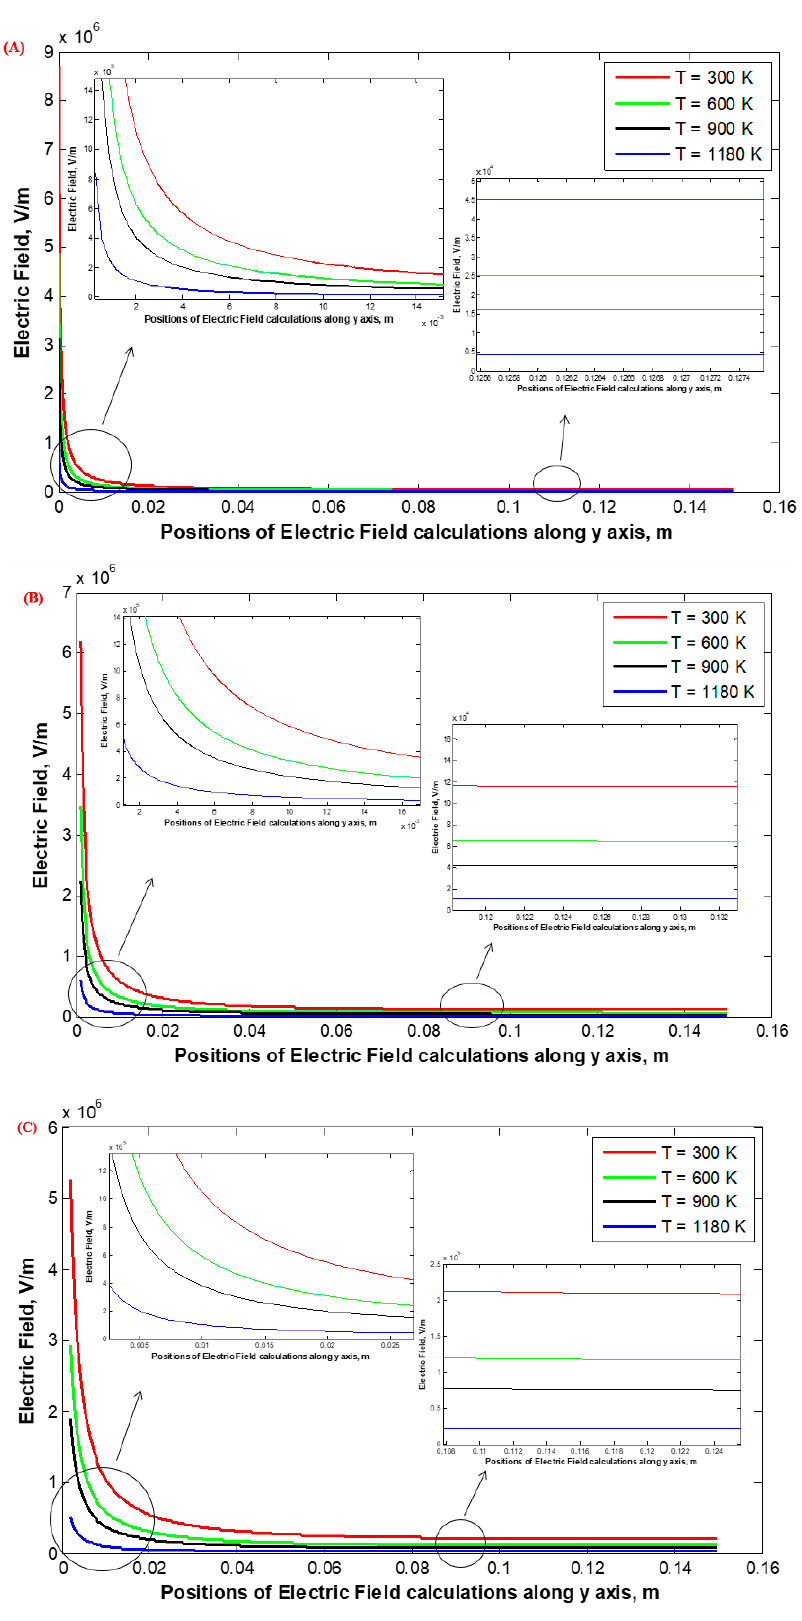
Figure 19. Electrostatic field along the Y -axis of the multi-discharge wire WDESP (three-wire) at a high temperature: ( A ) r c = 0. 26, ( B ) r c = 0. 935, and ( C ) r c = 1.975 mm.